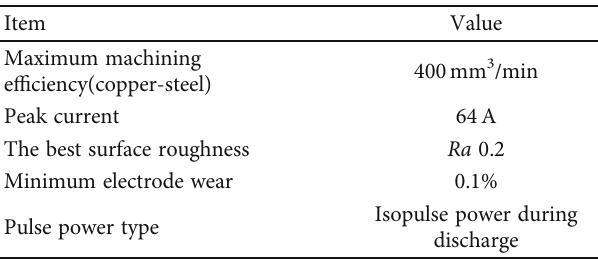
Table 1: Performances of